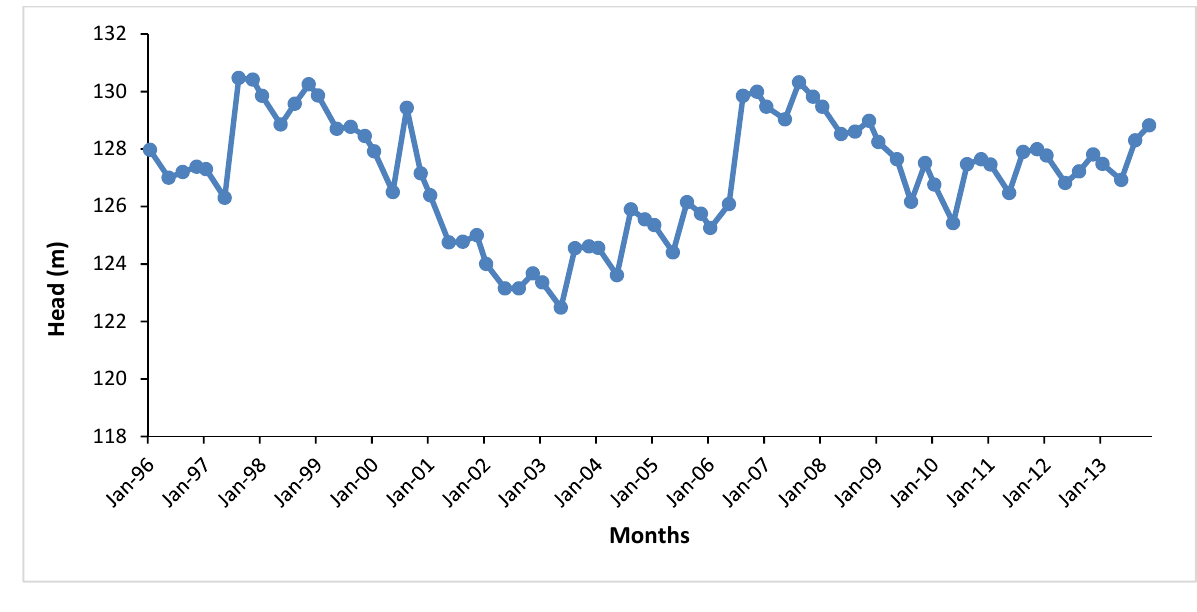
Figure 6. Central Ground Water Board groundwater head trends for the Meghraj watershed from January 2005 to November